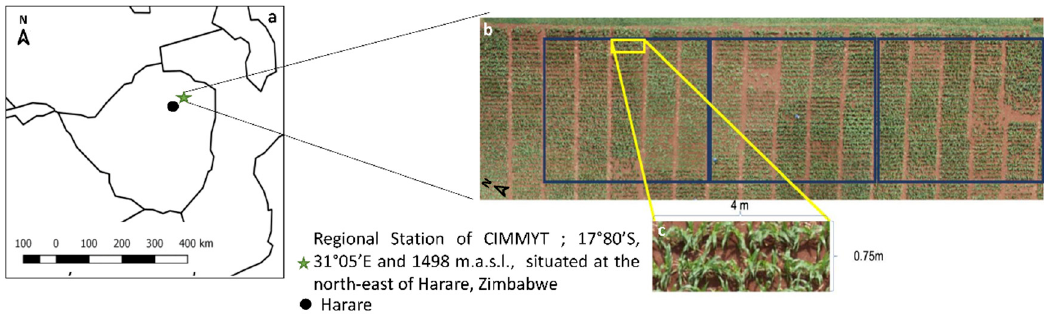
Figure 1. ( a ) Position of the regional station of International Center for Maize and Wheat Improvement (CIMMYT) in Harare, Zimbabwe. ( b ) Red–green–blue (RGB) aerial orthomosaic of the 192 plots, with 64 genotypes and 3 replicas (three blue box) per each one, under low managed nitrogen (LOW). ( c ) A plot with specific details of length and width.